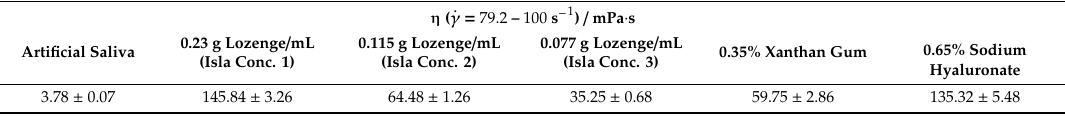
Table 2. Quantification of the mean viscosity between 79.2 s − 1 and 100 s − 1 , mean ± standard deviation.